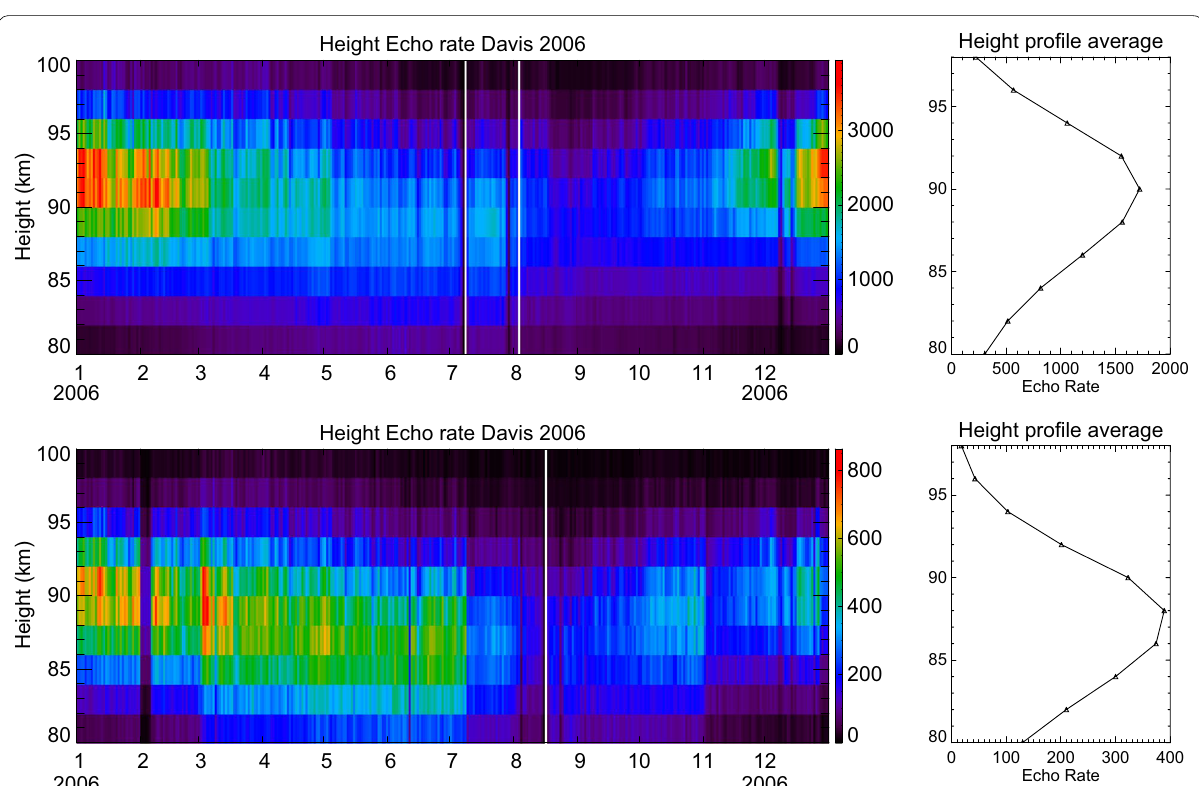
Fig. 1 2006 Davis 33.2 MHz (top left) and 55 MHz (bottom left) meteor radar detections. The line plots on the right-hand side represent the cor- responding 33.2 MHz (top right) and 55 MHz (bottom right) mean echo rates for each height averaged over the